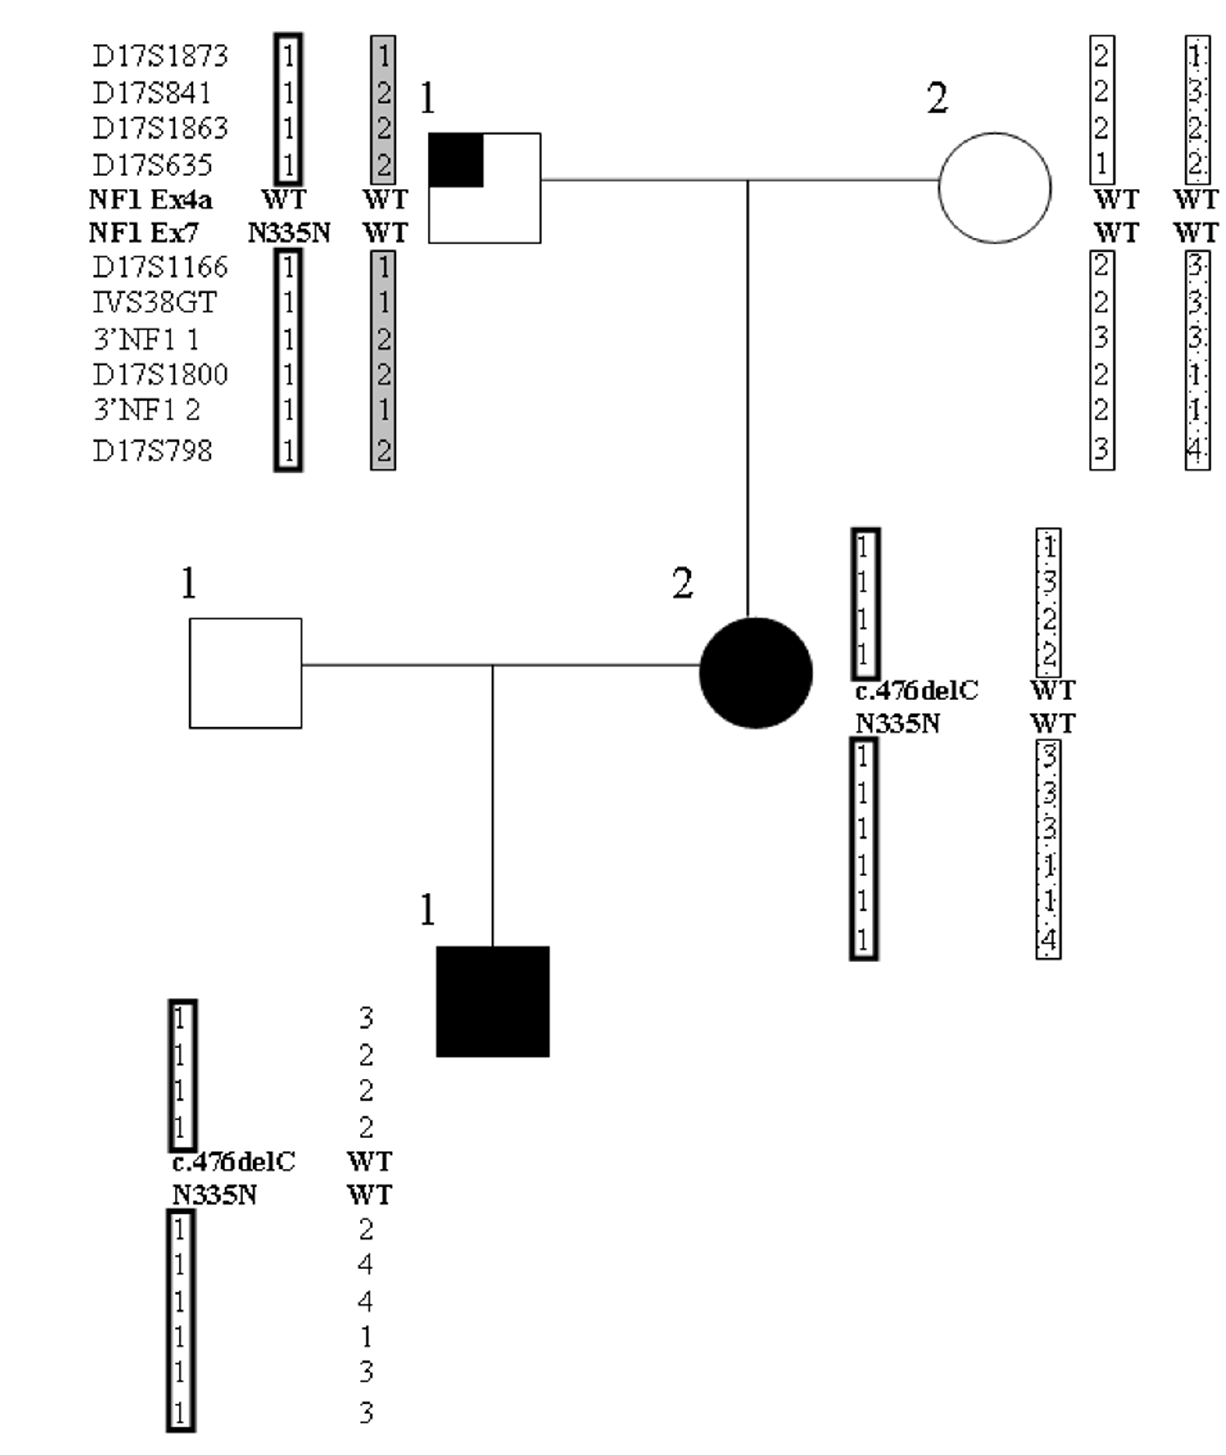
Figure 1 Family NF-01, showing pedigree numbers by generation and person number (i.e., I:1 to III:1). NF1 affected individuals are denoted by a blackened symbol, unaffected by an unblackened symbol. The individual carrying isolated neurofibromas is denoted by a partially blackened symbol. The haplotypes from linkage analysis of chromosome 17 are shown. Individuals II:2 and III:1 carry the N335N silent mutation and the c.476delC deletion, while individual I:1 carries only the N335N